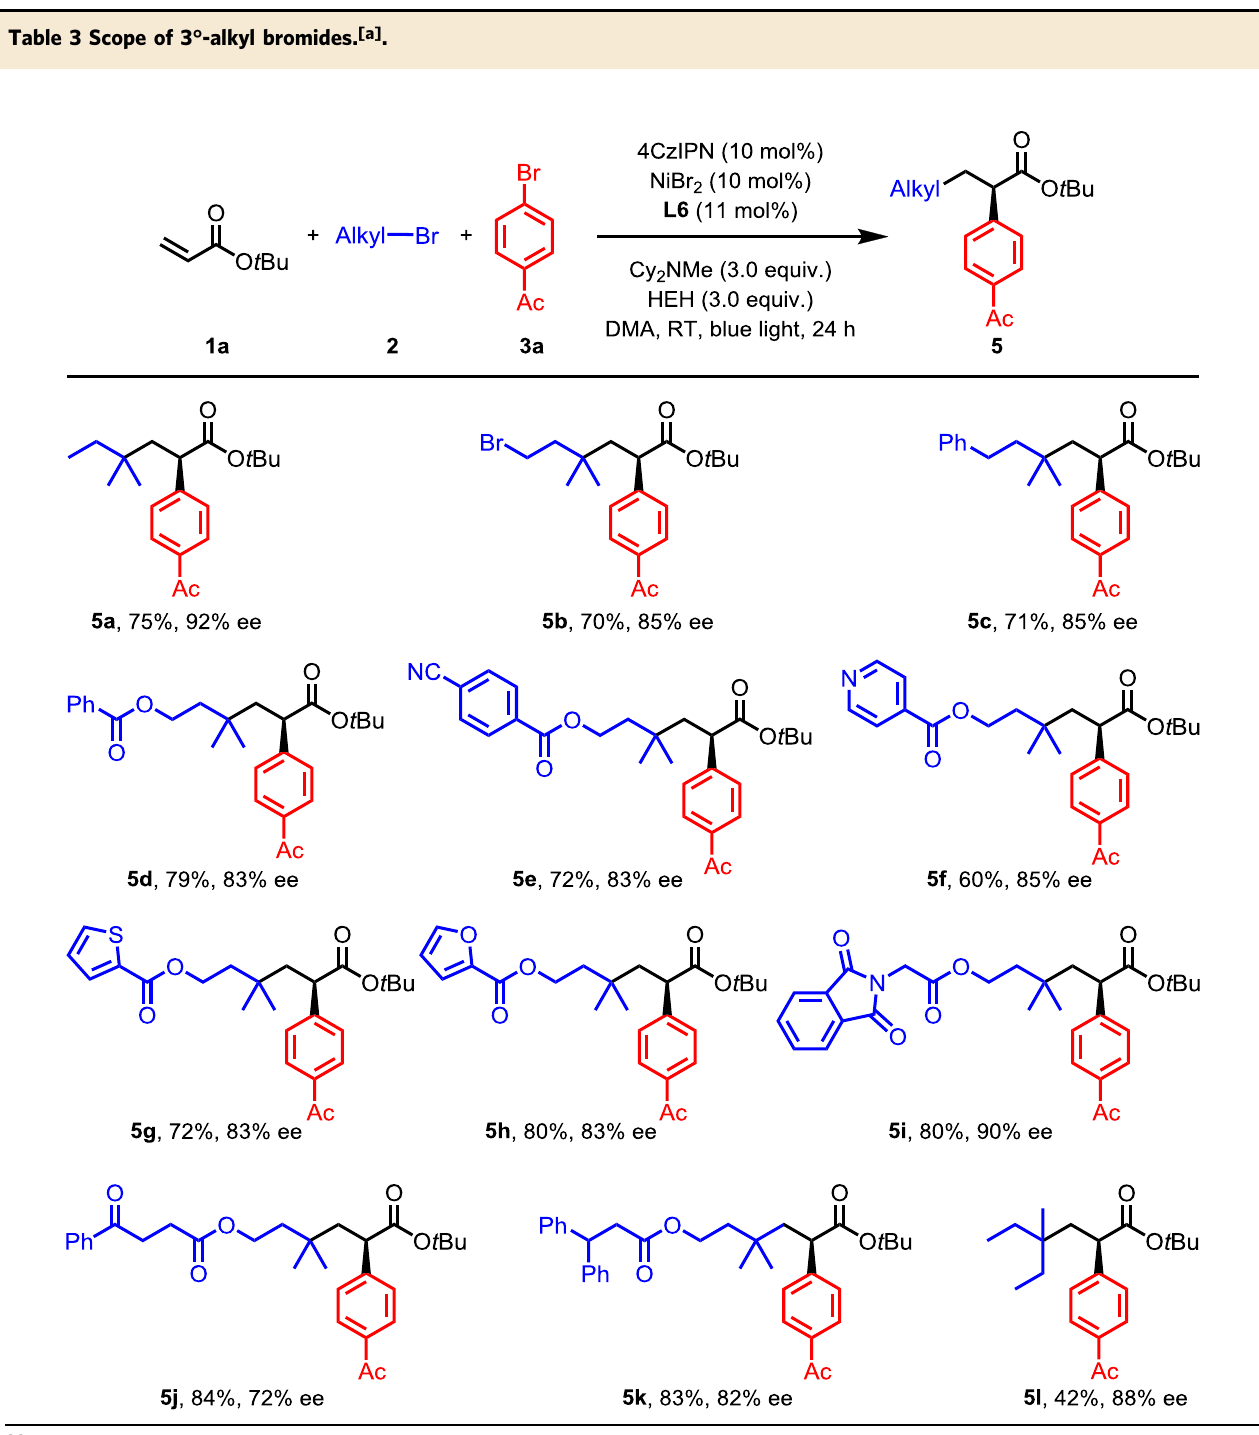
Table 3 Scope of 3°-alkyl bromides. [a]